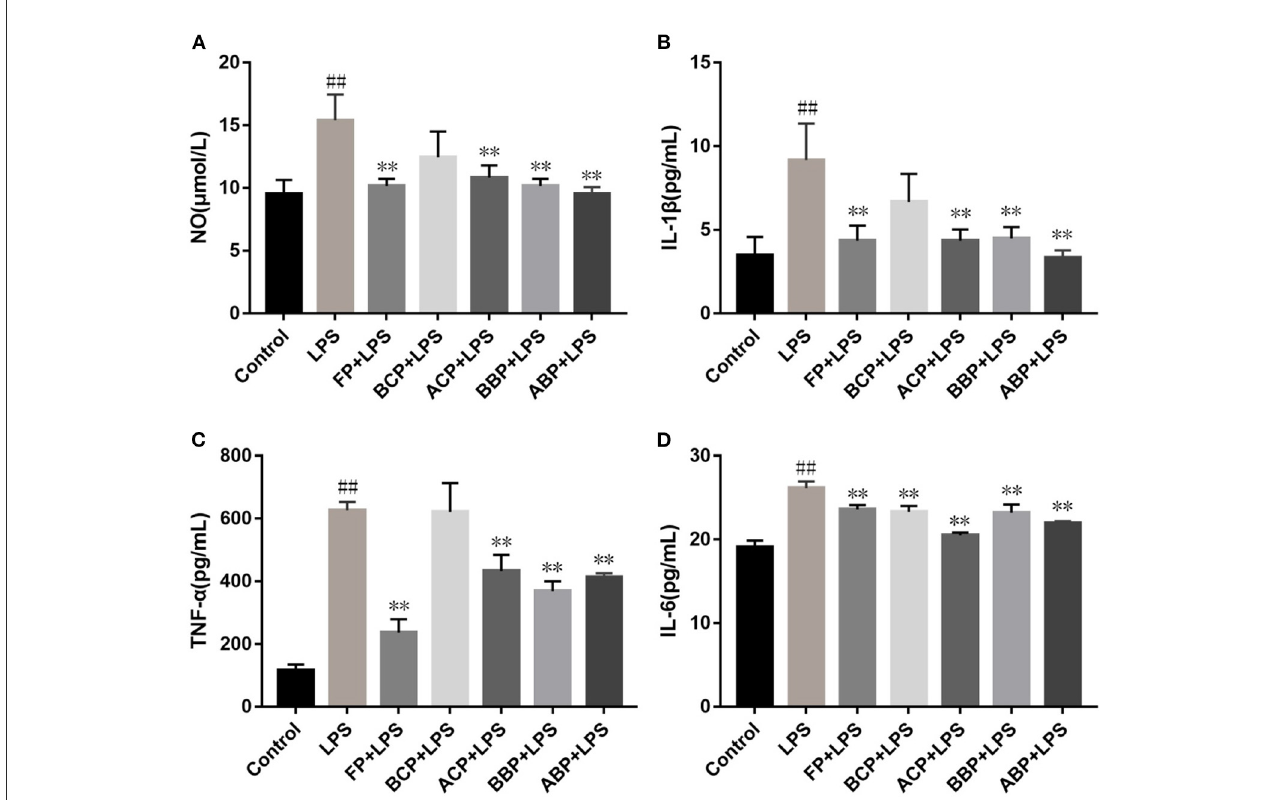
FIGURE5 Influence of hazel leaf phenolics on NO (A) , IL-1 β (B) , TNF- α (C) , and IL-6 (D) in LPS-stimulated cells, values are expressed as mean ± SD, ## p < 0.01 vs. Control, ** p < 0.01 vs. LPS.